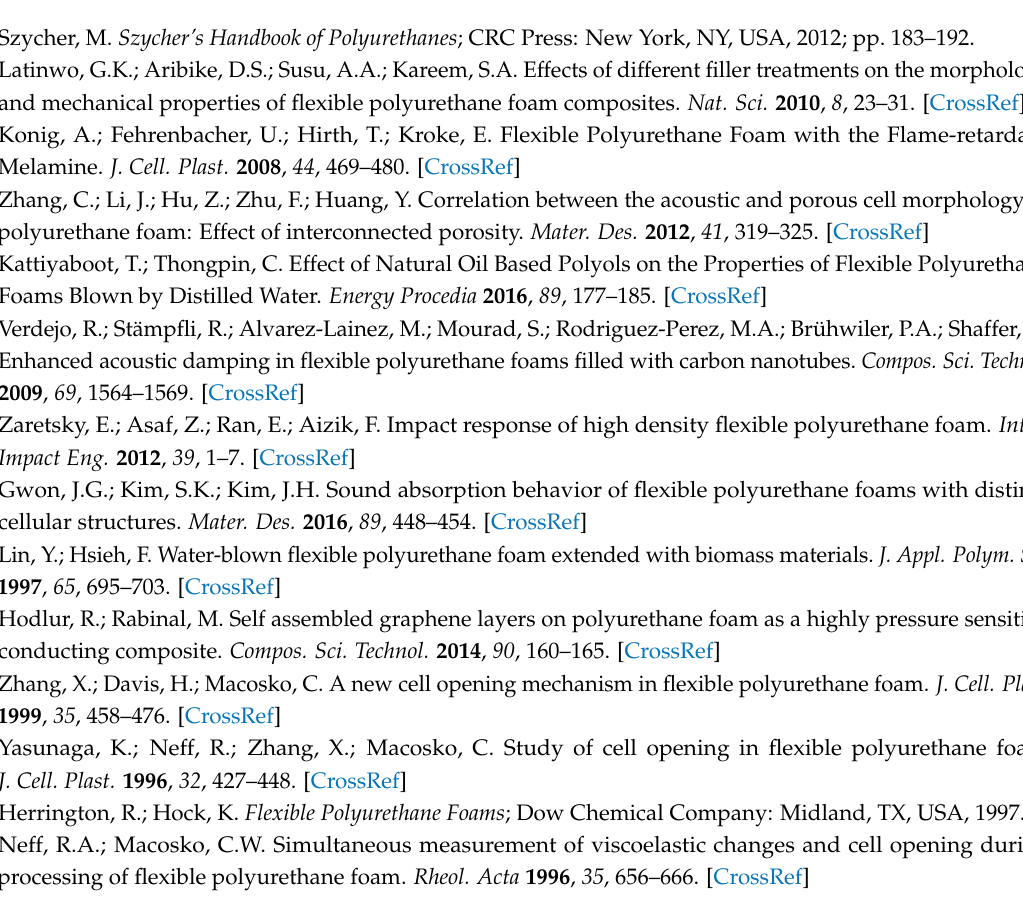
Supplementary Materials: Figure S1: Photographs of TF-3000 (PPG)/ISB mixture samples containing different amount of ISB. The last numbers of the sample codes denote wt% of ISB in the samples, Figure S2: Photographs of FPUFs investigated in this study, Figure S3: Schematic illustration of crosslinked network structures of (a) PU without ISB and (b) those with ISB, Figure S4: Temperature-dependent FTIR spectra of PUF-I0 and PUF-I5: (a) PUF-I0; (b) PUF-I5; (c) PUF-I0 expanded at 1660–1850 cm − 1 ; (d) PUF-I5 expanded at 1660–1850 cm − 1 ; (e) PUF-I0 spectra of PU films based on different concentrations of ISB, Figure S6: FTIR spectra of different FPUFs after curing at room temperature for 1 h, Figure S7: Photographs of PUF-I0 (left) and PUF-I5 (right) left at room temperature for 30 days, Figure S8: Free radical scavenging activity of ISB solution in methanol (0.3 mM) by DPPH method at room temperature, Table S1: Bio-based content of FPUFs investigated, Table S2: Sample code and formulation for PU films with various ISB content, Table S3: Shear viscosity of PPG/ISB mixture at 25 ◦ C, Table S4: Average cell size, average thickness of cell walls, and the number of cells per unit area of FPUFs with various ISB content before and after thermal